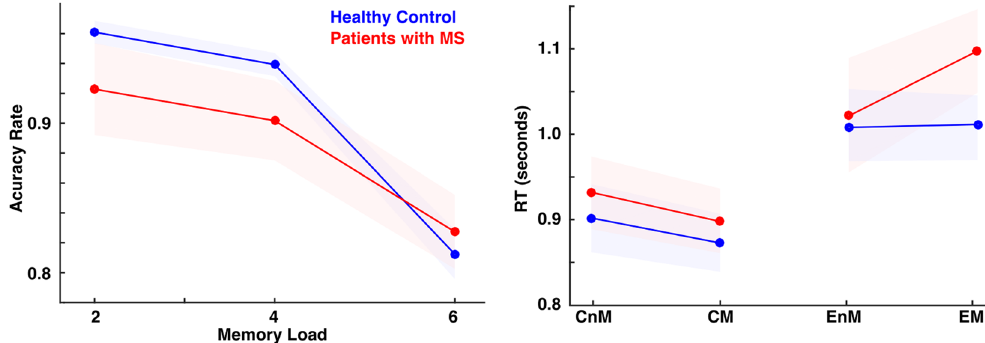
Figure 2. Behavioral Analyses. Left panel shows the Accuracy Rate per memory load. Right panel shows the reaction time (RT) for memory load 6 separated by correct responses for no-matched target (CnM), correct responses for matched target (CM), incorrect responses for no-matched targets (EnM), incorrect responses for matched targets (EM). Red represents patients with multiple sclerosis (MS) and blue healthy control. Colored areas represent standard error of